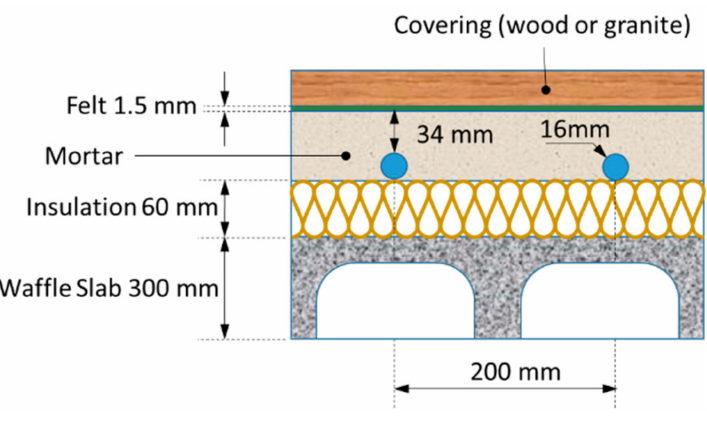
Figure A2. Radiant flooring layout.